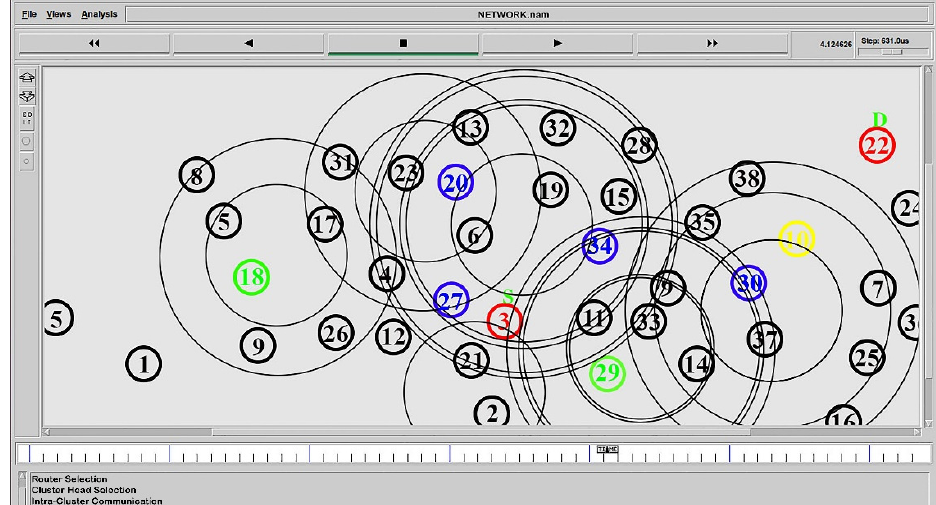
Figure 2. SDS heterogeneous network simulation in process.